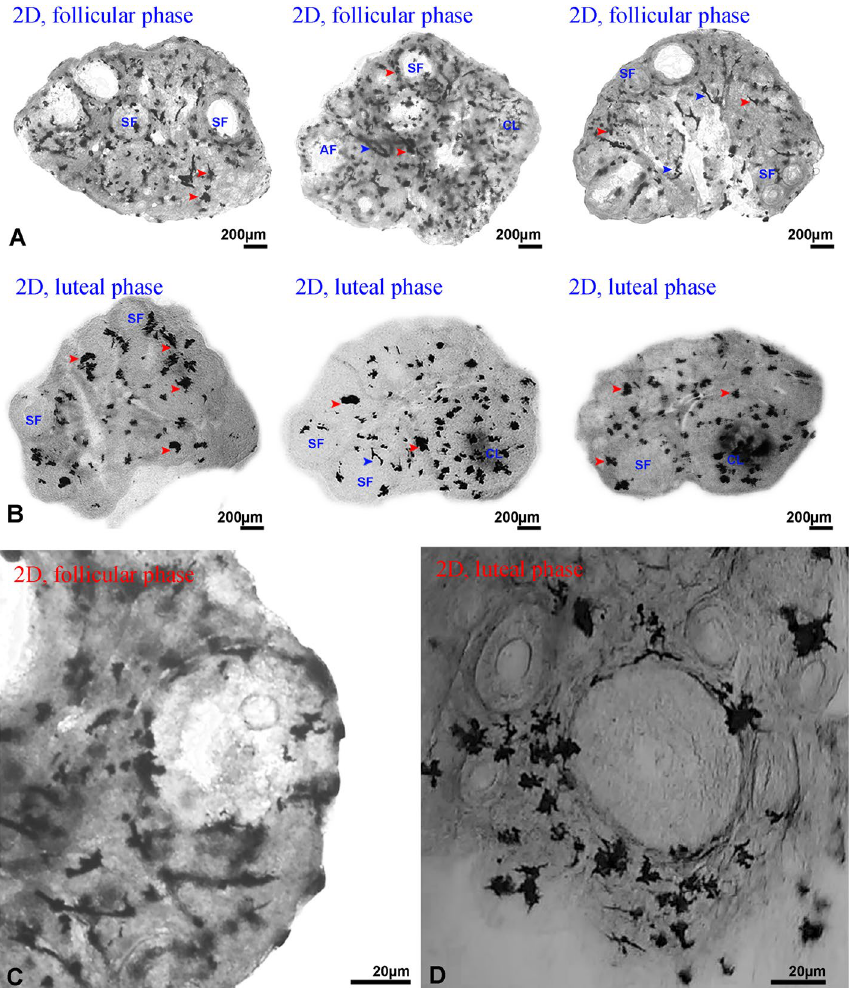
Figure 1. Mouse ovarian sections were stained with Golgi–Cox method. ( A ) Two-dimensional follicular phase ovary. ( C ) Distribution of ganglia around follicular phase ovarian follicles. ( D ) Distribution of ganglia around luteal phase ovarian follicles. The ganglia (red arrow head), and neural filaments (blue arrow head) are stained black. Secondary follicles (SF), Antral follicles (AF) and corpus luteum (CL) are also seen (all images are gray scale